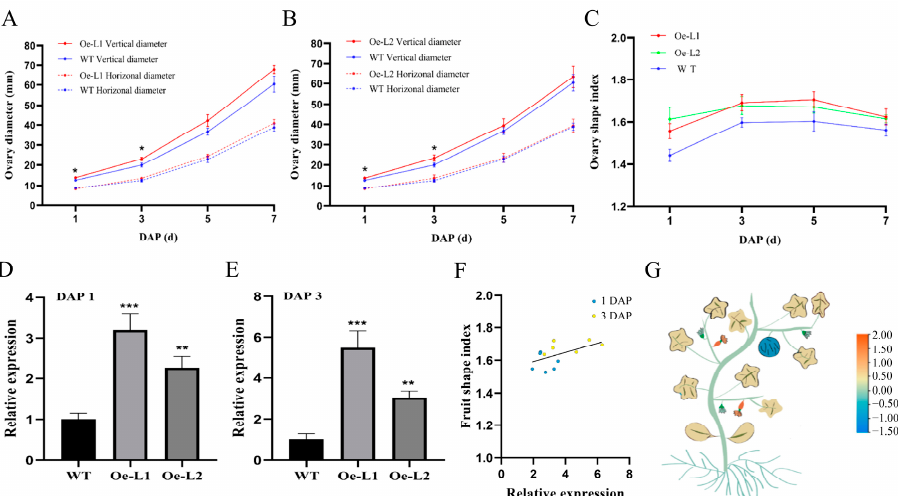
Figure 9. Statistical data of CmSUN23-24 -overexpressed in transgenic fruits. ( A , B ) Vertical and horizonal diameter comparison of the fruits at 1 DAP, 3 DAP, 5 DAP, and 7 DAP in transgenic lines and WT. ( C ) Statistical analyses of ovary shape index in transgenic lines and WT in DAP 1~7. ( D , E ) qRT-PCR analyses of CmSUN23-24 expression in the ovary at 1 DAP and 3 DAP. Oe-L1 and Oe-L2 indicate CmSUN23-24 -overexpressed transgenic lines. ( F ) Scatterplot analysis showed the positive relevant of FSI and CmSUN23-24 expression. ( G ) Schematic model of relative expression of CmSUN23-24 in different melon tissues. * p value < 0.05; ** p value < 0.01; *** p value < 0.001.